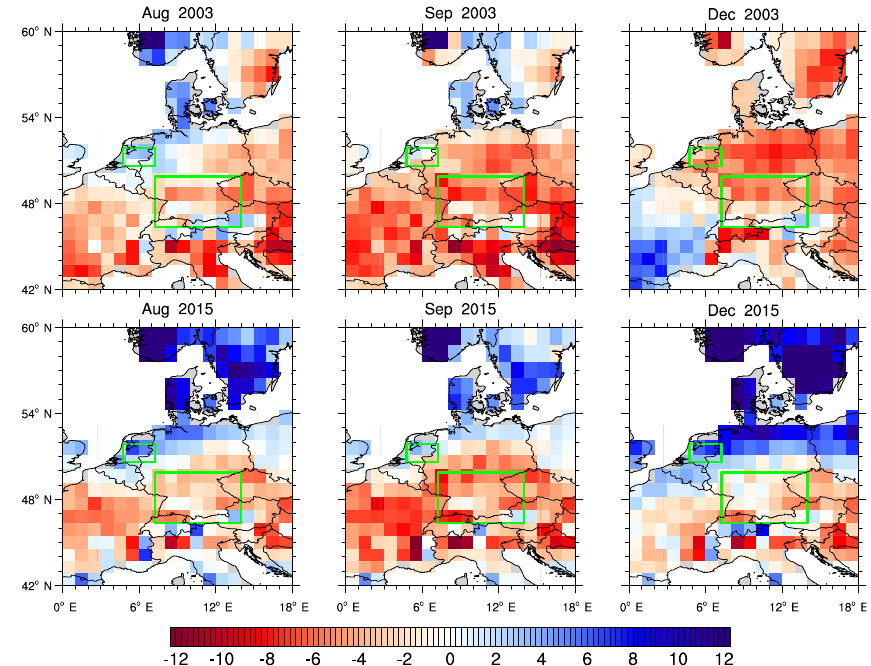
Figure A7. Groundwater anomalies (cm) based on GRACE and CLM model outputs for the available 3 common months (August, September, and December) during the 2003 and 2015 drought events (top panels), estimated by removing the total surface water storage anomaly (TOW, which is the combination of soil moisture, canopy storage, and snow water equivalent) from the GRACE-TWS anomaly (Fig.